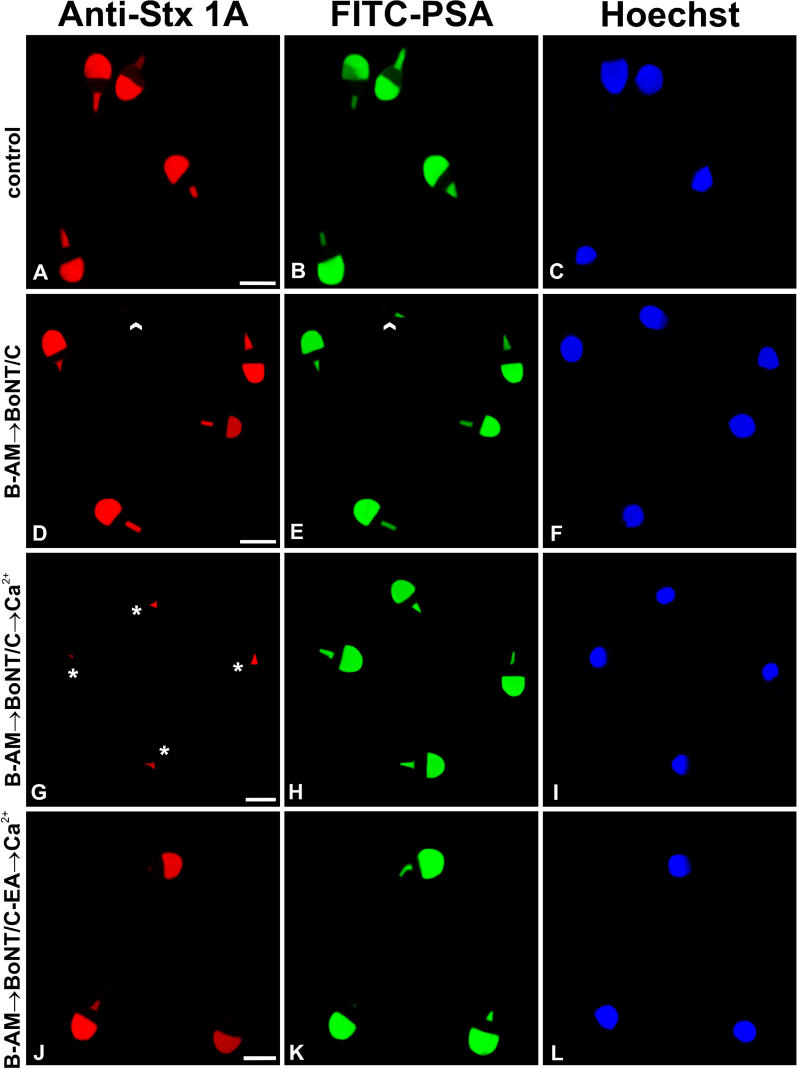
Effect of BoNT/C on Syntaxin1A ImmunofluorescenceSperm were incubated with 100 nM BoNT/C (15 min at 37 °C) as explained in Figure 4. The cells were then fixed and triple-stained with an anti-syntaxin1A antibody that recognizes an epitope trimmed by the toxin (red; [A, D, G, and J]), FITC-PSA to differentiate between reacted and intact sperm (green; [B, E, H, and K]), and Hoechst 33258 to visualize all cells in the field (blue; [C, F, I, and L]). Notice that spontaneously reacted sperm were negative for syntaxin1A staining (arrowheads in [D] and [E]). BoNT/C had no effect on resting sperm (compare [A–C] with [D–F]). However, labeling in sperm stimulated with 10 μM Ca2+ in the presence of BAPTA-AM to prevent exocytosis (observe that PSA staining is not affected) was significantly reduced by the toxin (asterisks, [G]). In contrast, the same experimental condition in the presence of the protease-inactive toxin (BoNT/C-EA) had no effect (J–L). Bars = 5 μm.